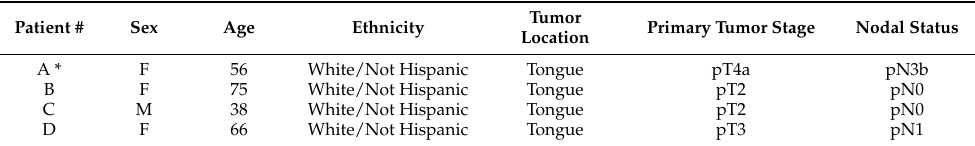
Table 2. Localization of cathepsin S in human oral cancer tissue.